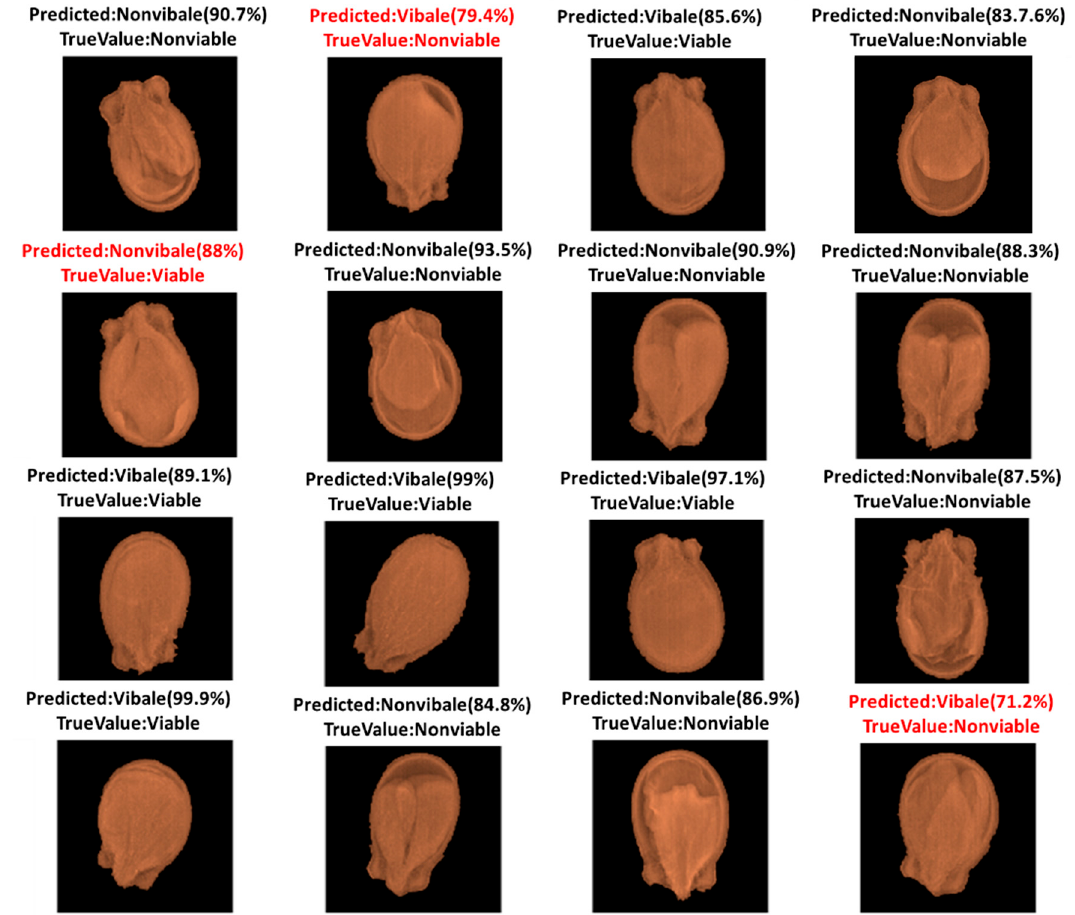
Figure 7. Randomly selected prediction class of the samples using ResNet50.